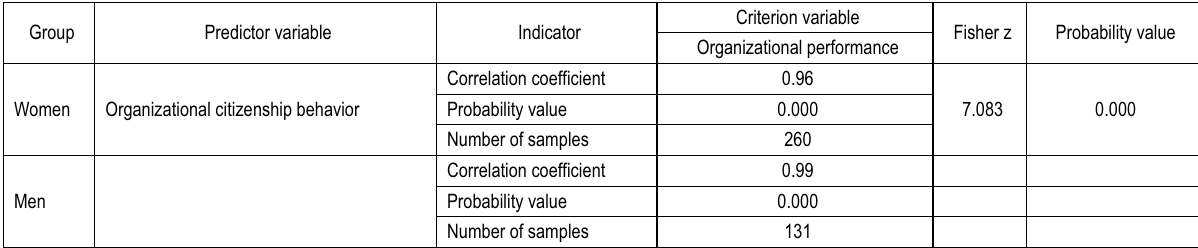
Table 8. Relationship between organizational citizenship behavior and organizational performance in terms of